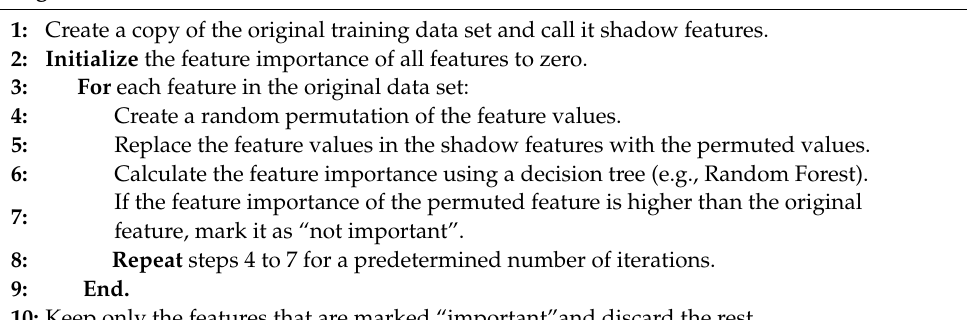
Algorithm 1: Boruta Feature